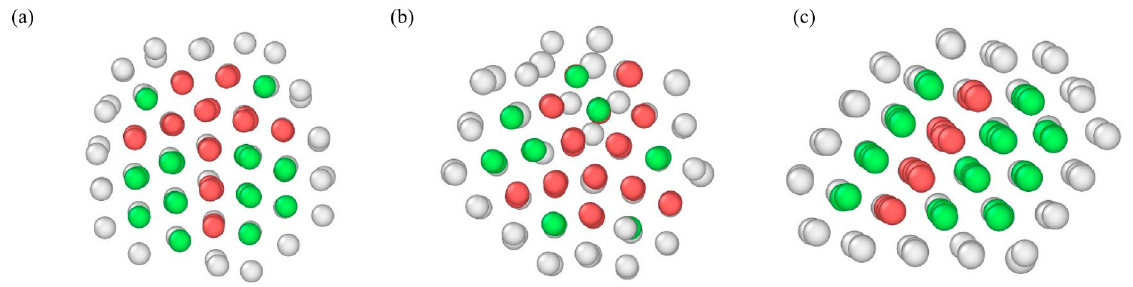
Figure 5. Structure type of the clusters at different temperatures. ( a ) Cu 2 Ag 133 850 K, ( b ) Cu 113 Ag 22 600 K, ( c ) Cu 132 Ag 3 950 K.